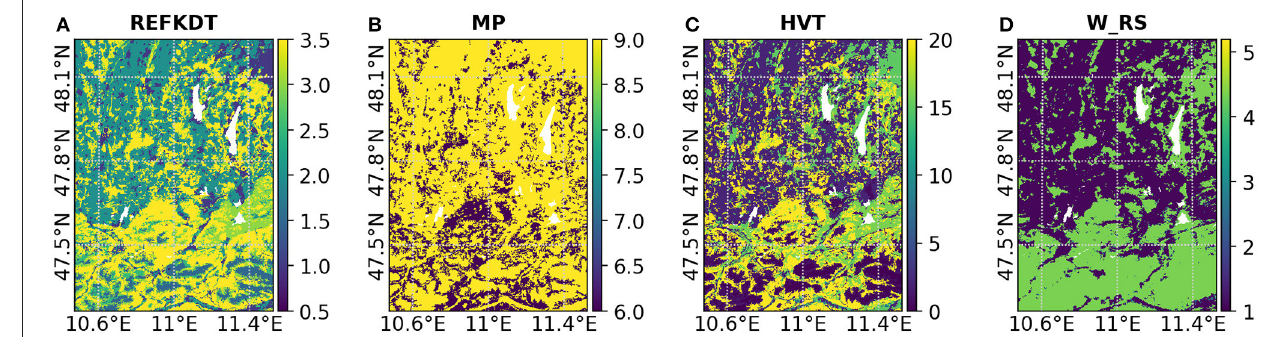
FIGURE 2 | Spatial plots of parameters estimated during the data assimilation experiment (A) REFKDT (infiltration capacity scaling parameter), (B) MP (slope of Ball-Woodrow-Berry stomatal conductance model), (C) HVT (vegetation height in meters), and (D) W_RS (control soil surface layer resistance to evaporation).